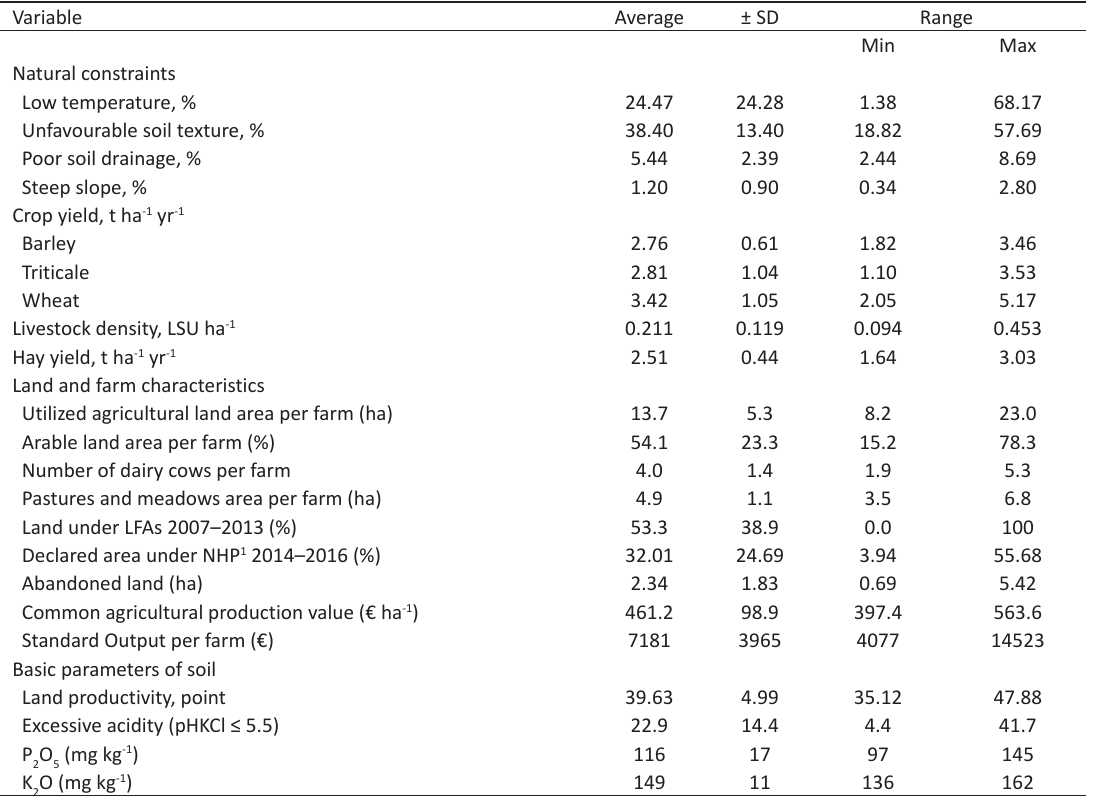
Table 1. Summary of the variables used in the study Variable Natural constraints